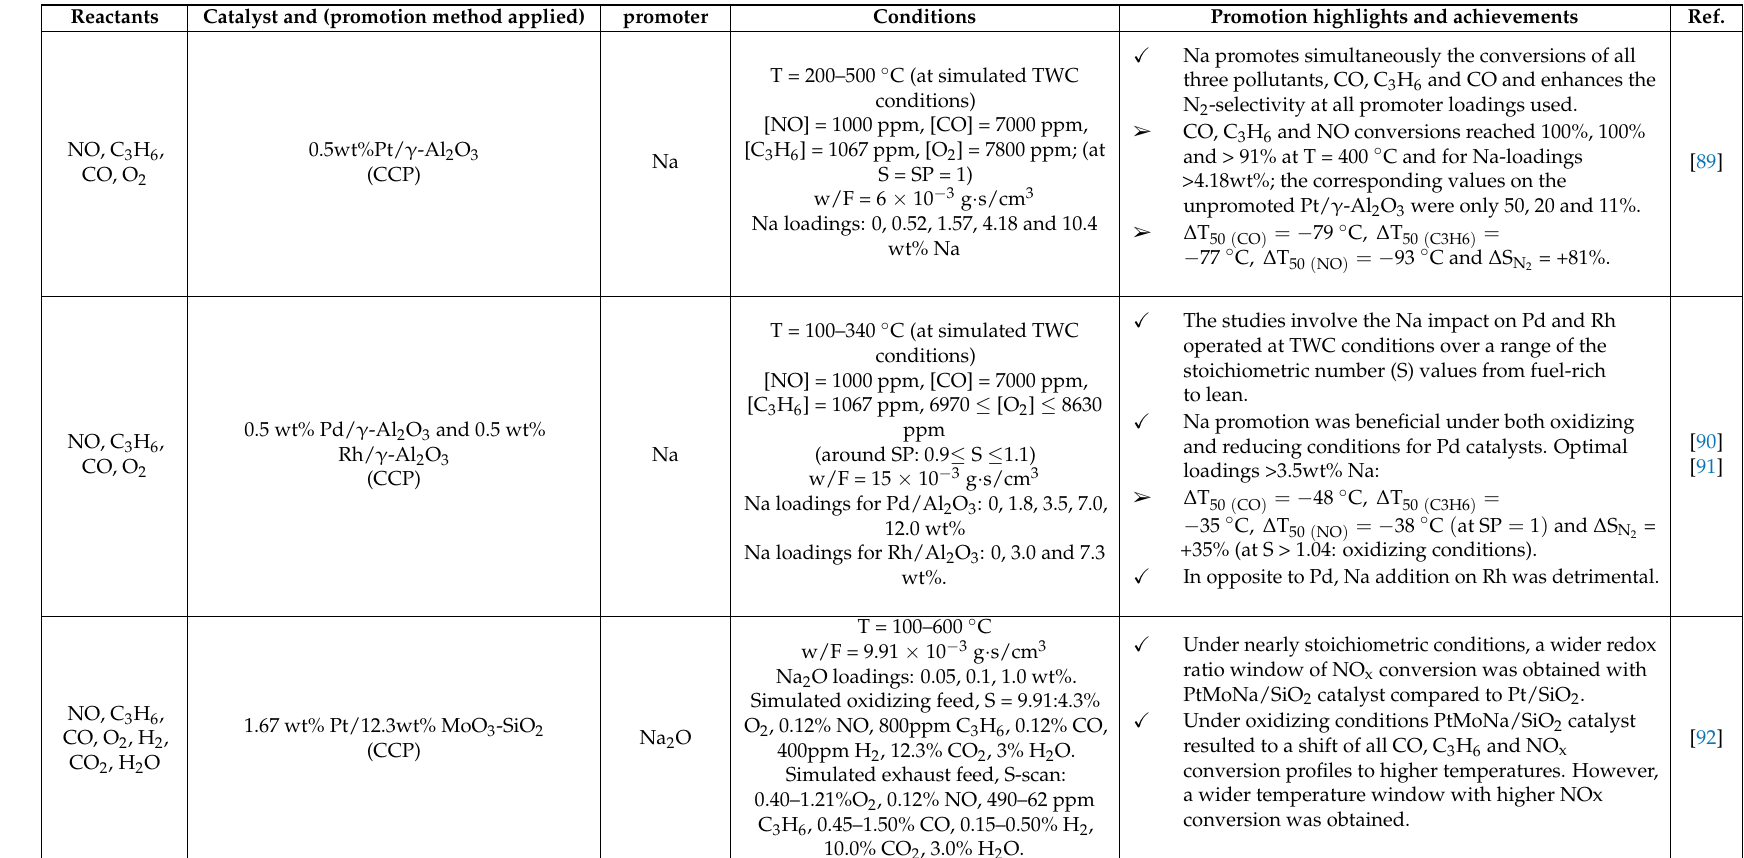
Table 6. Electropositive promotion of PGM-catalysts operated under simulated automotive exhaust